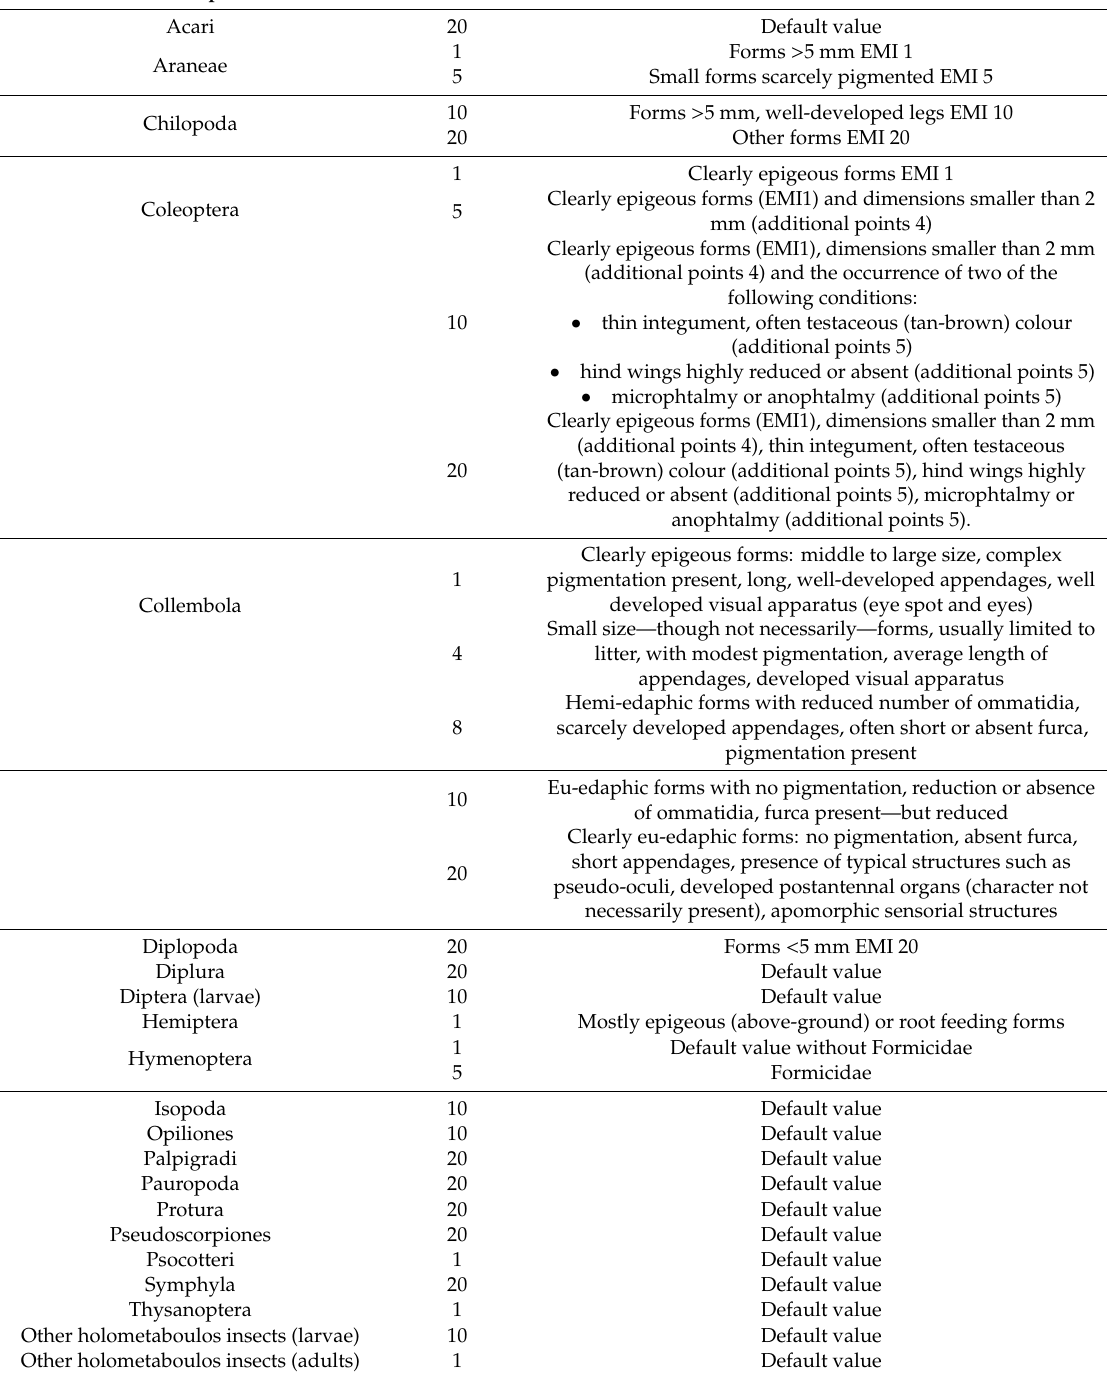
Table 3. Groups identified in all the analysed samples. The EMI scores has been attributed following values proposed by Parisi et al.